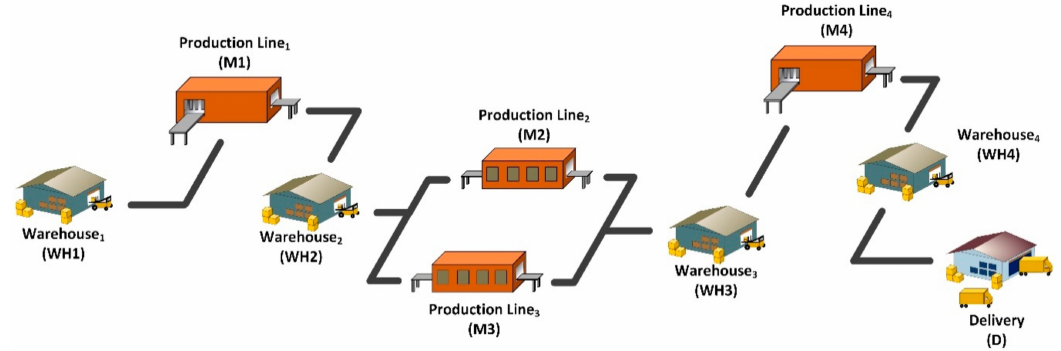
Figure 1. Production process